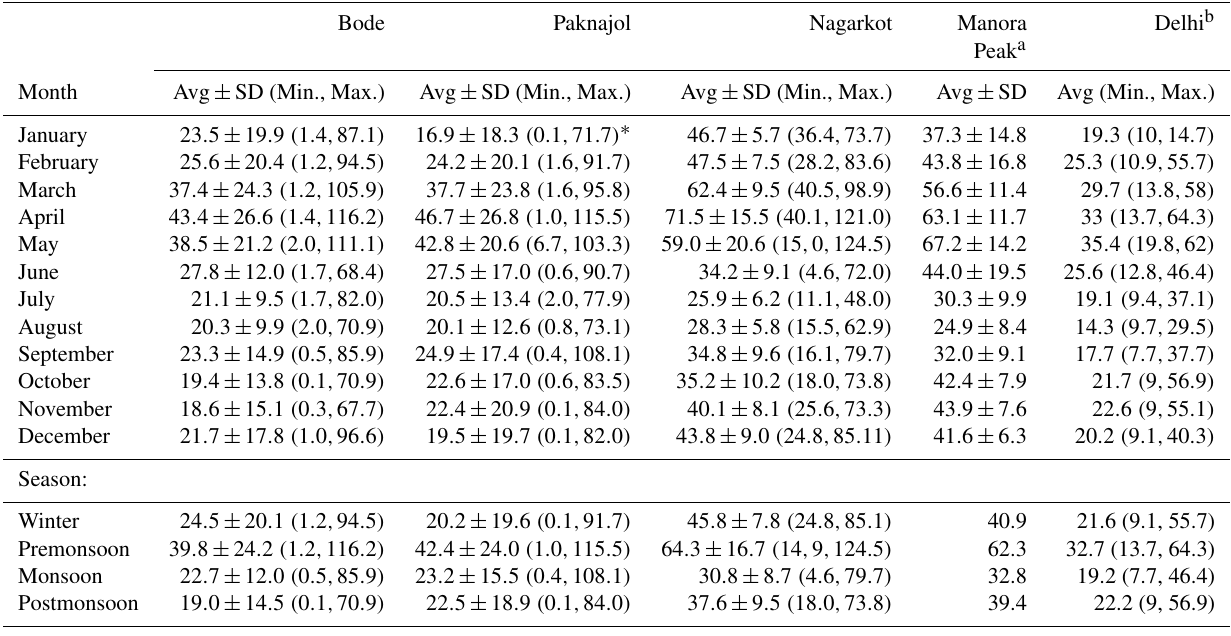
Table 3. Summary of the monthly average ozone mixing ratios (ppb) at four sites ∗ in the Kathmandu Valley, Nepal during 2013–2014 and two sites (Manora Peak and Delhi) in India. Avg – average, SD – standard deviation, Min. – minimum, Max. – maximum. Bode Paknajol Nagarkot